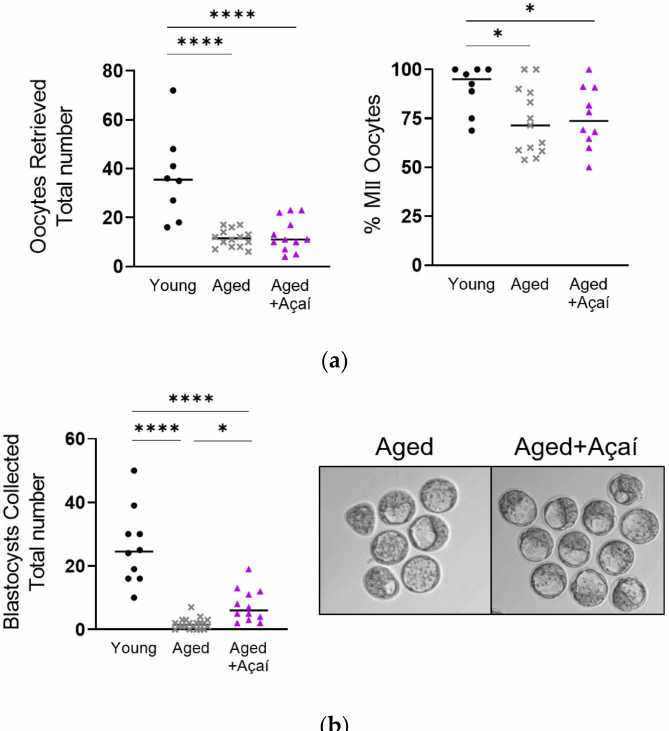
Figure 1. Effects of age and aça í treatment on oocyte and blastocyst development. ( a ) Numbers of total oocytes retrieved from superovulated mice, and the proportion that were MII vs. degenerate (n = 8 young, 14 aged, 12 aged + aça í ). ( b ) Numbers and representative images of D4 embryos collected from superovulated, bred mice (n = 10 young, 20 aged, 12 aged + aça í ). The data were analyzed by the Kruskal–Wallis test with Dunn’s multiple comparisons when the overall effect p < 0.05. * p < 0.05, **** p <